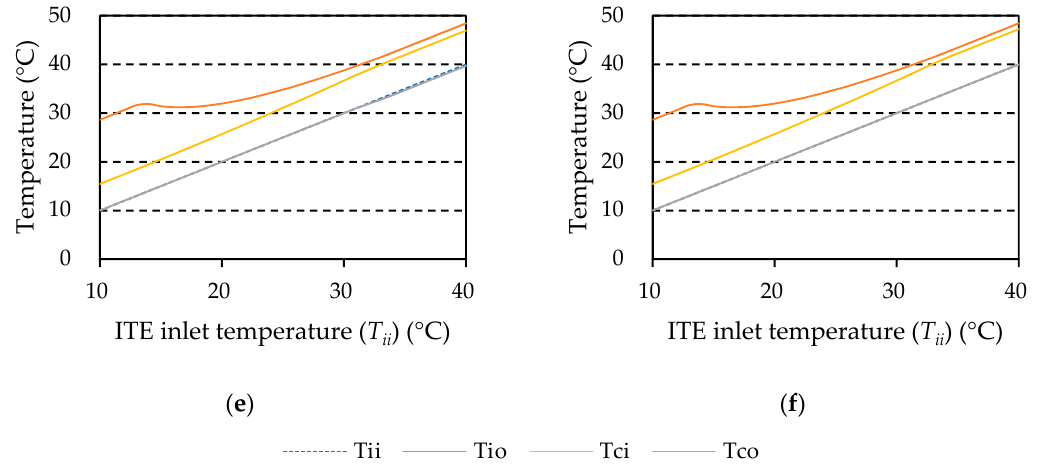
Figure 18. Temperature of each part with respect to ITE inlet temperature ( T ii ): ( a ) ASE = 0.5, ( b ) 0.6, ( c ) 0.7, ( d ) 0.8, ( e ) 0.9, and ( f ) 1.0.